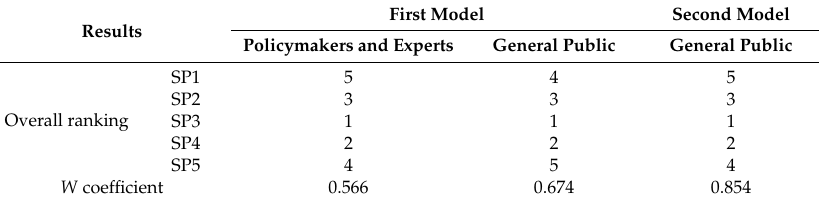
Table 6. Analysis of the plausibility results for participants in the first and second decision- making